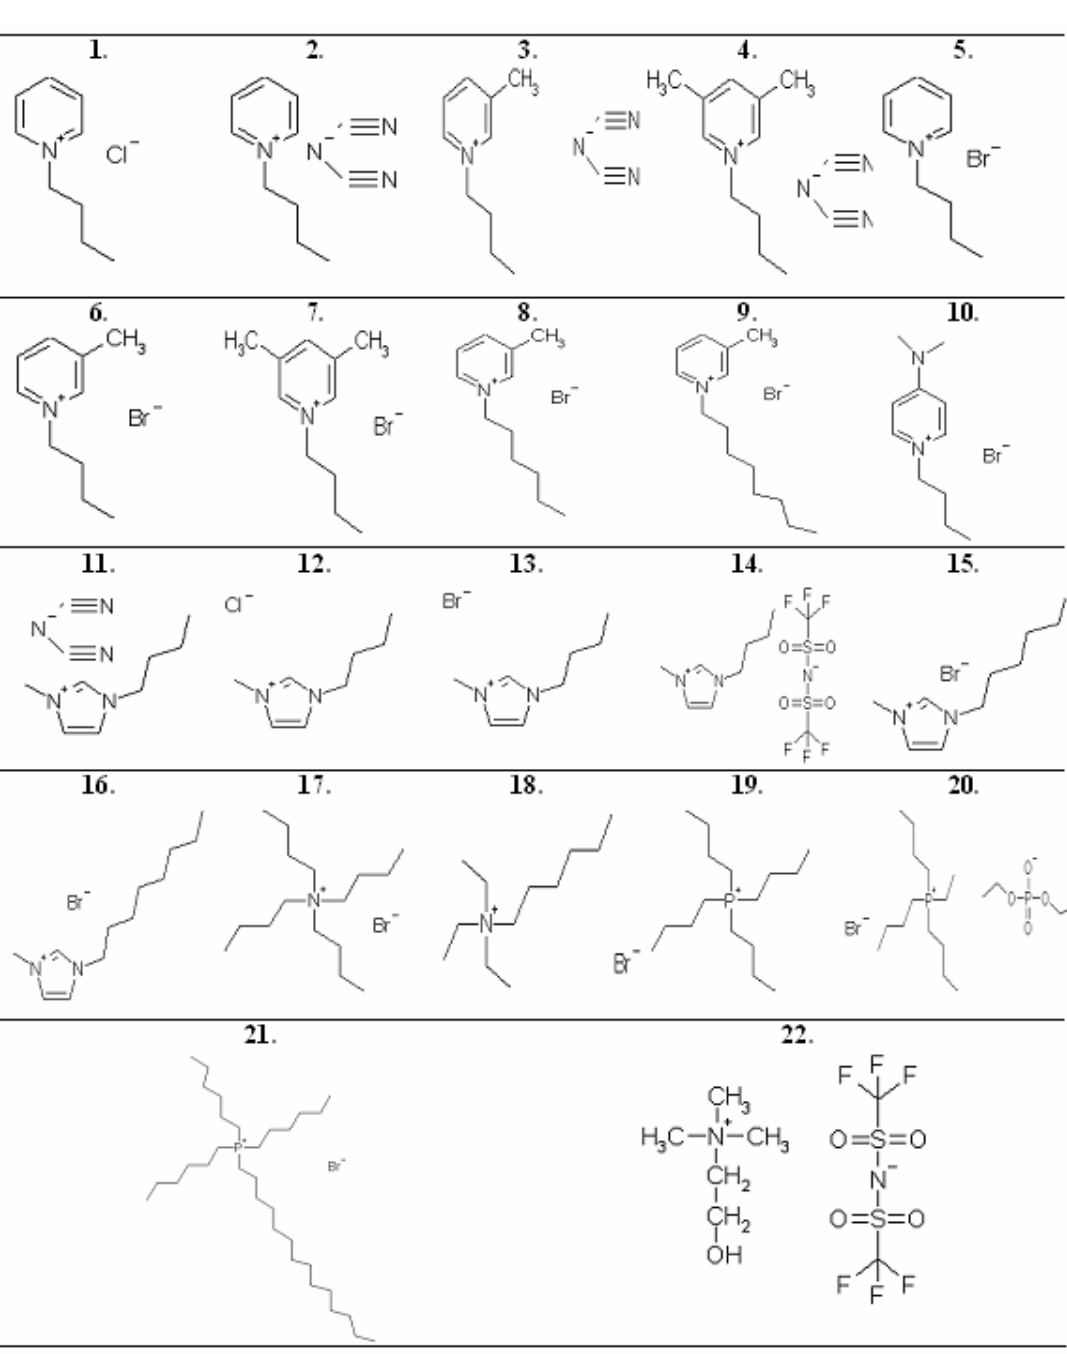
Figure 2: The ionic liquids acting on Vibrio fischeri species studied in this